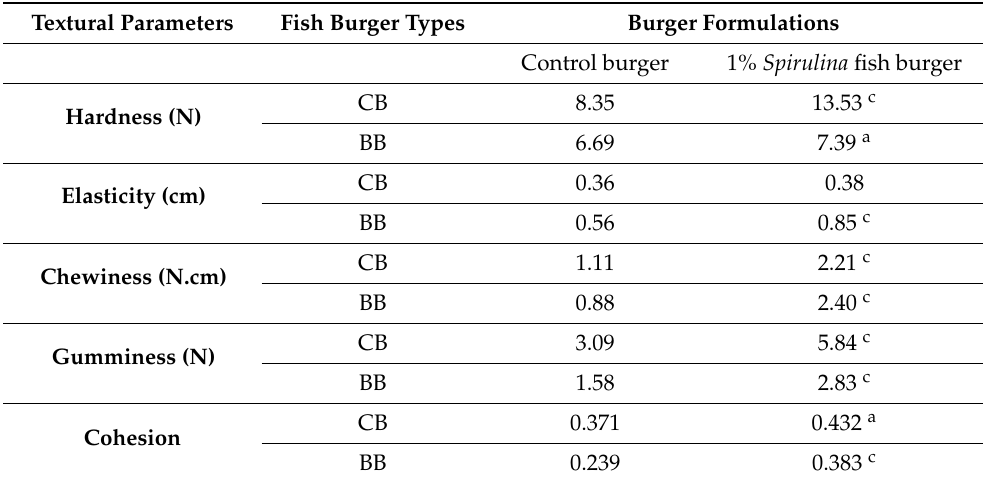
Table 3. Parameters obtained using texture analyzer for control and fortified burgers with di ff erent concentrations of Spirulina